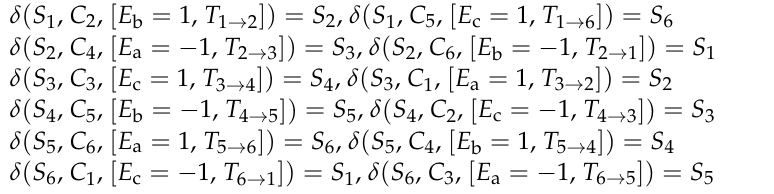
Table 4. Variable Constraints of the EFSM.